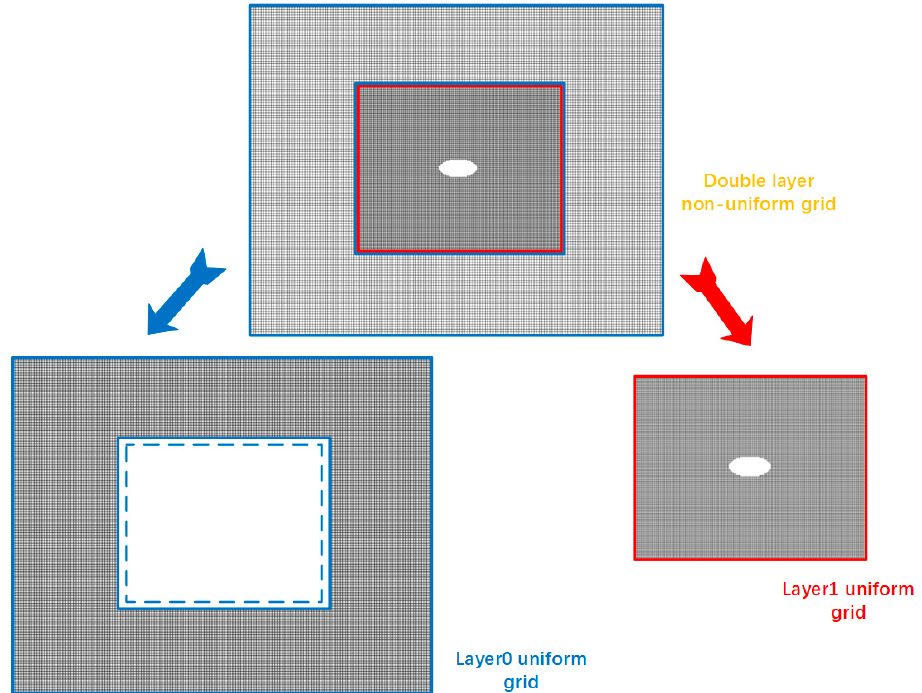
Figure 22. The two-layer non-uniform grid structure is decomposed into Layer0 uniform grid computational domain (the original outer coarse grid) and Layer1 uniform grid computational domain (the original inner fine grid). The Layer0 uniform grid computational domain also contains the white box area outside the blue dashed line (coarse and fine grid value exchange buffer area). Table 3. The first three columns of the table present detailed results on the MPI-dependent perfor- mance of the computational domains of the three grid structures, with reference throughput (cid:1846) (cid:3019) and nesting efficiency\eta calculated from these data, and the results were used to evaluate parallel al- gorithms.